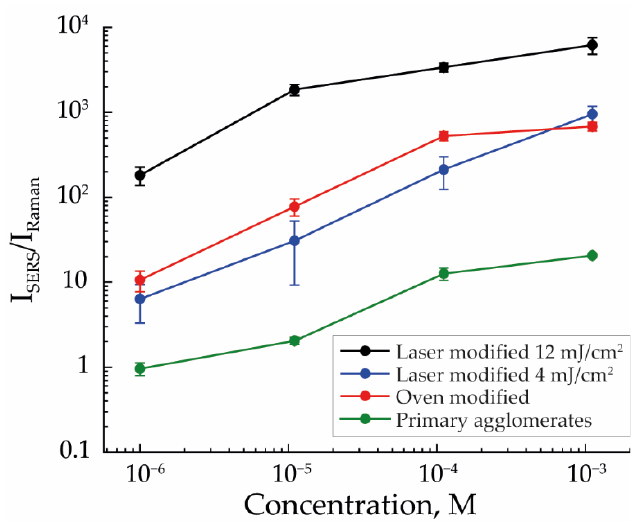
Figure 6. The efficiency of MB detection for SERS structures fabricated from primary agglomerates, thermally modified NPs, and laser-modified NPs with 4 mJ/cm 2 and 12 mJ/cm 2 energy density with an aerosol flow rate of 50 mL/min.